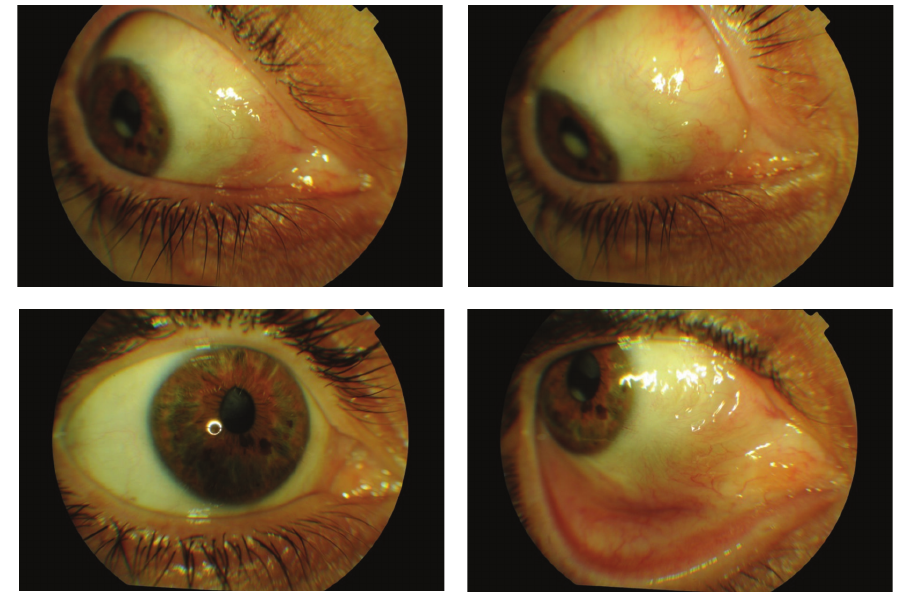
Figure 4: Postoperative